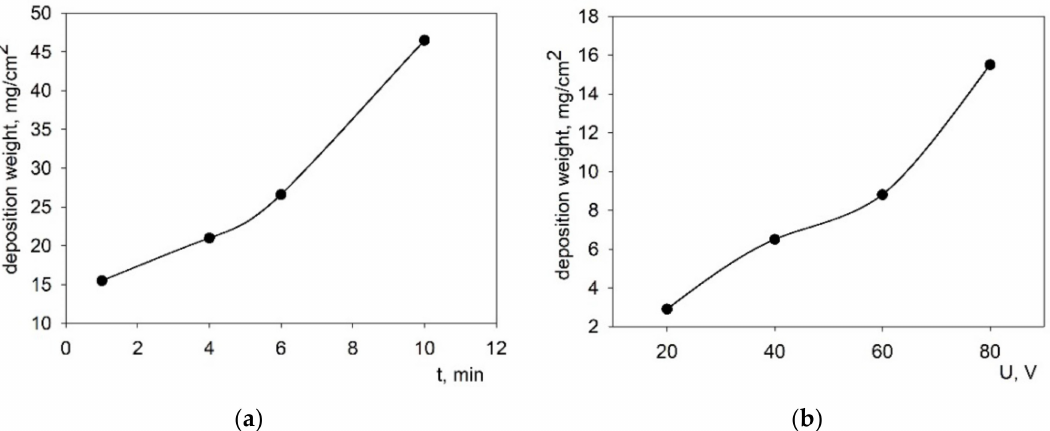
Figure 4. Growth of the deposited weight during the EPD from the suspension of 10 g/L of the BCSCuO powder with iodine (0.4 g/L): ( a ) as a function of time at a constant voltage of 80 V; ( b ) as a function of voltage at a constant deposition time of 1 min.